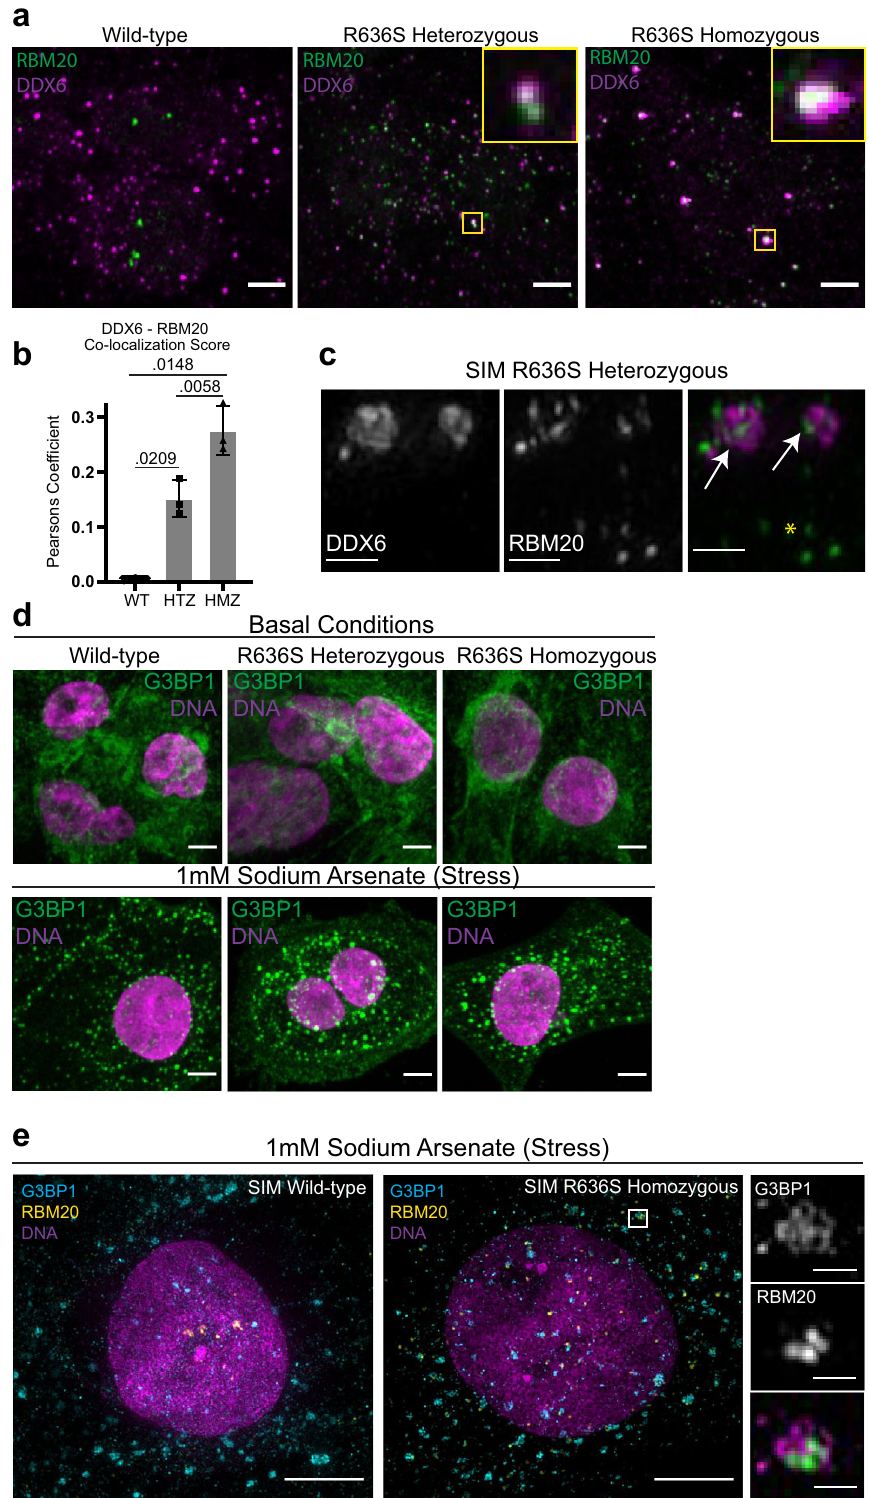
transcriptional gene regulation 46 . While the precise cause of and functional relevance of splicing differences in mutant and WT remain to be determined, these data suggest a more complex model in which loss of canonical RBM20 splicing leads to altered functional products involved in cardiac contractile regulation, potentially augmented by pathogenic circular RNAs,